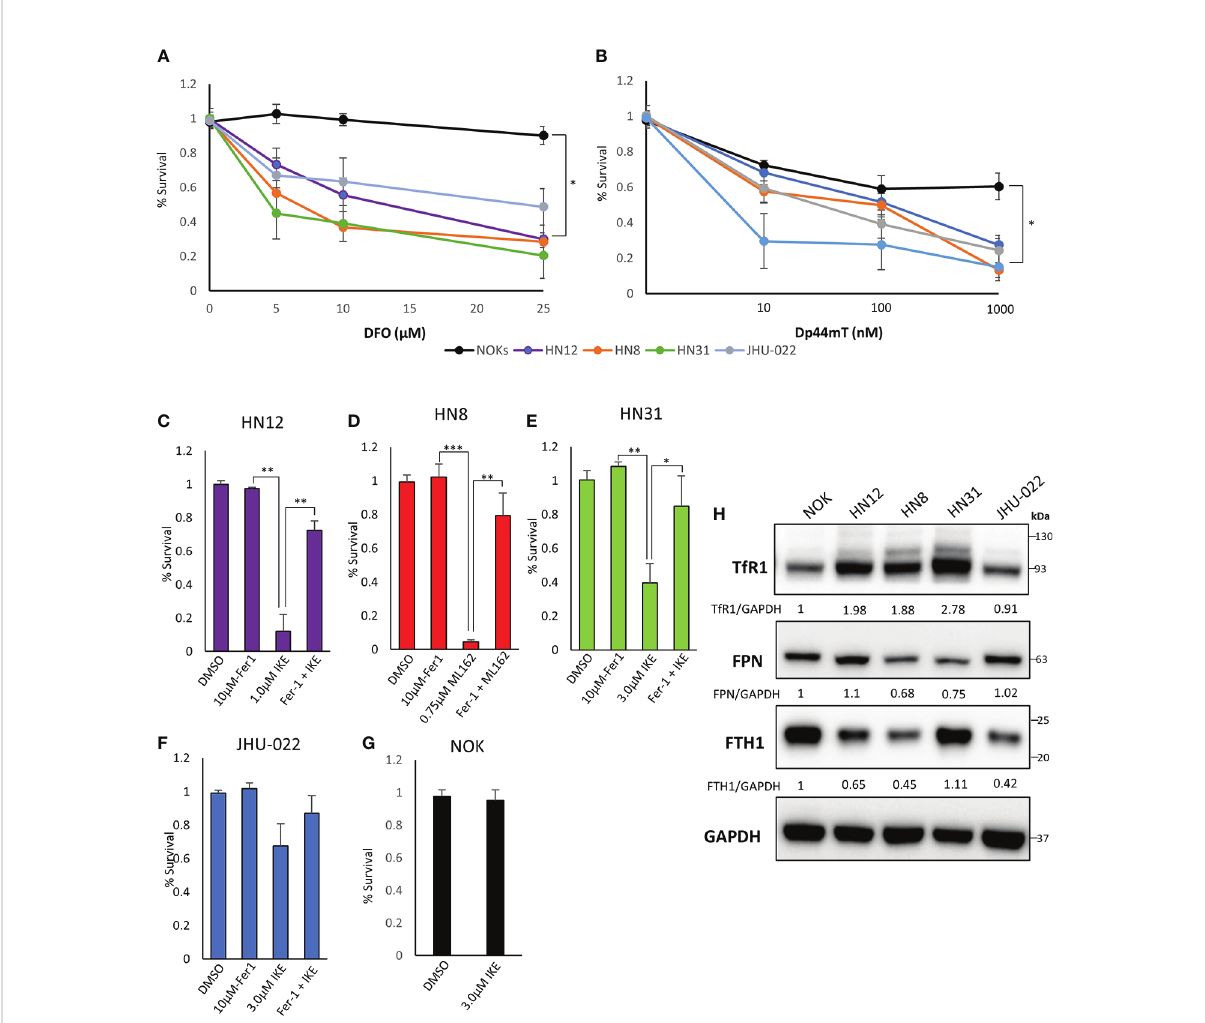
FIGURE 1 HNSCC cell lines exhibit an increased dependence on iron and are susceptible to iron chelation and ferroptosis. (A) Cells were grown with increasing amounts of deferoxamine (DFO) for 72 hours and cell viability was assessed via CellTiter-Glo assay. (B) Cells were treated with the indicated amount of Dp44mT for 72 hours and cell viability was measured via CellTiter-Glo. (C – G) The indicated cell line was seeded and treated with a vehicle control (DMSO), Ferrostatin-1 (Fer-1, 10 m M), the indicated ferroptosis inducer (IKE or ML162), or a combination of both for 72 hours. Cell viability was measured via CellTiter-Glo assay. Values were normalized to a non-treated control with DMSO. (H) Western Blot of TFR1, FPN, FTH1, with GAPDH as a loading control. Quanti fi cation of TFR1, FPN, and FTH1 was performed using GAPDH as a loading control and normalized to the NOKs (*P<0.05; **P<0.01;